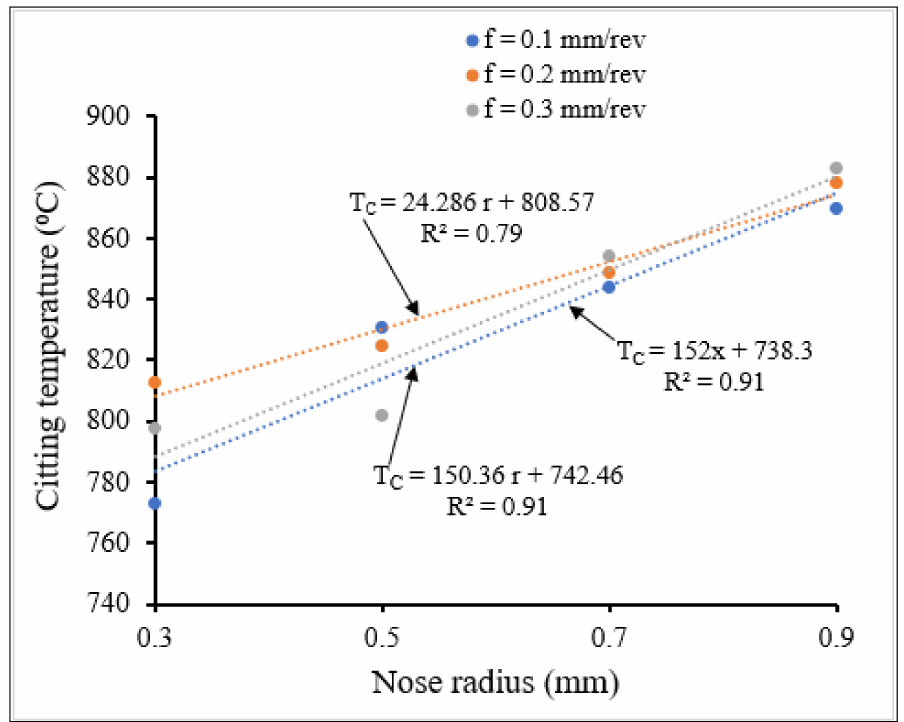
Figure 13. Variation of cutting temperature with large tool nose radius for different feed rates at V = 400 m/min, γ = 5 ◦